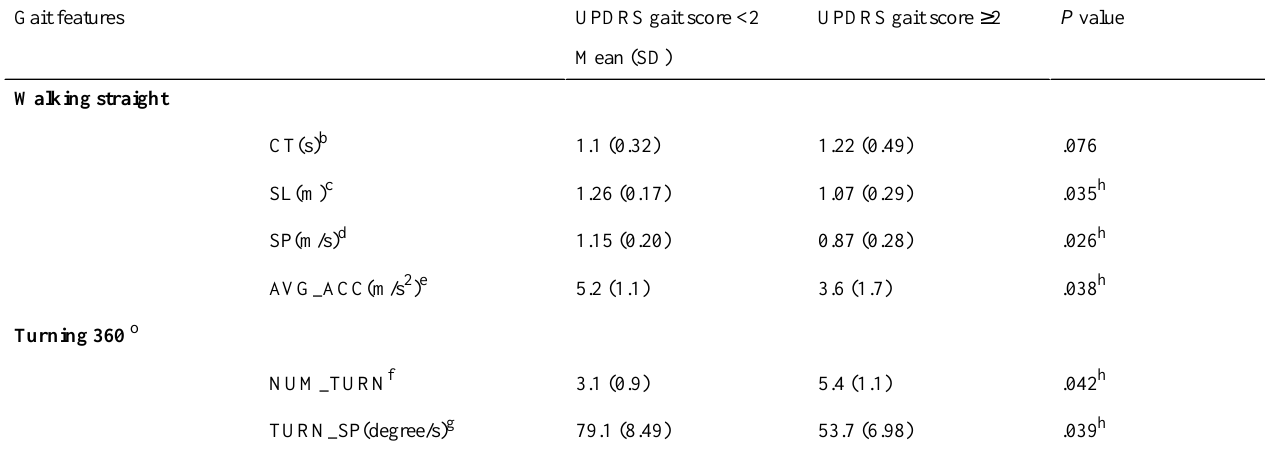
Table 5. Extracted motion features from walking and turning tests (results are divided into two groups, UPDRS a gait score <2 and UPDRS gait score ≥ 2.)